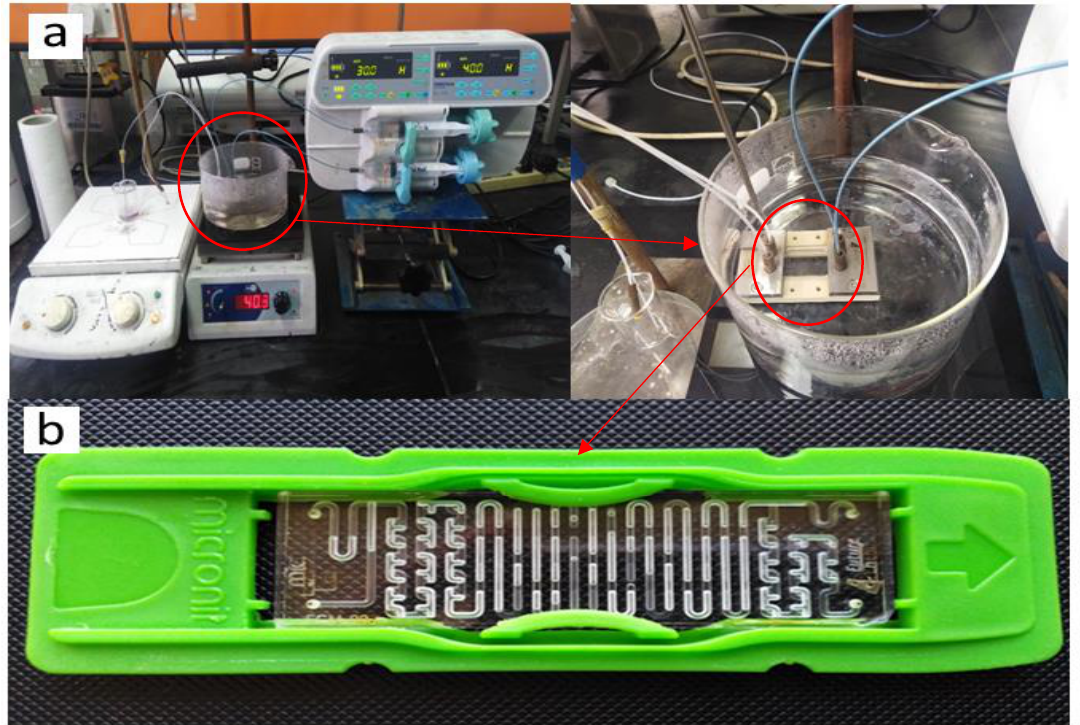
Figure 17. ( a ) An experimental setup for producing GNPs in a microreactor ( b ) A borosilicate glass microreactor with two inlets and two outlets.